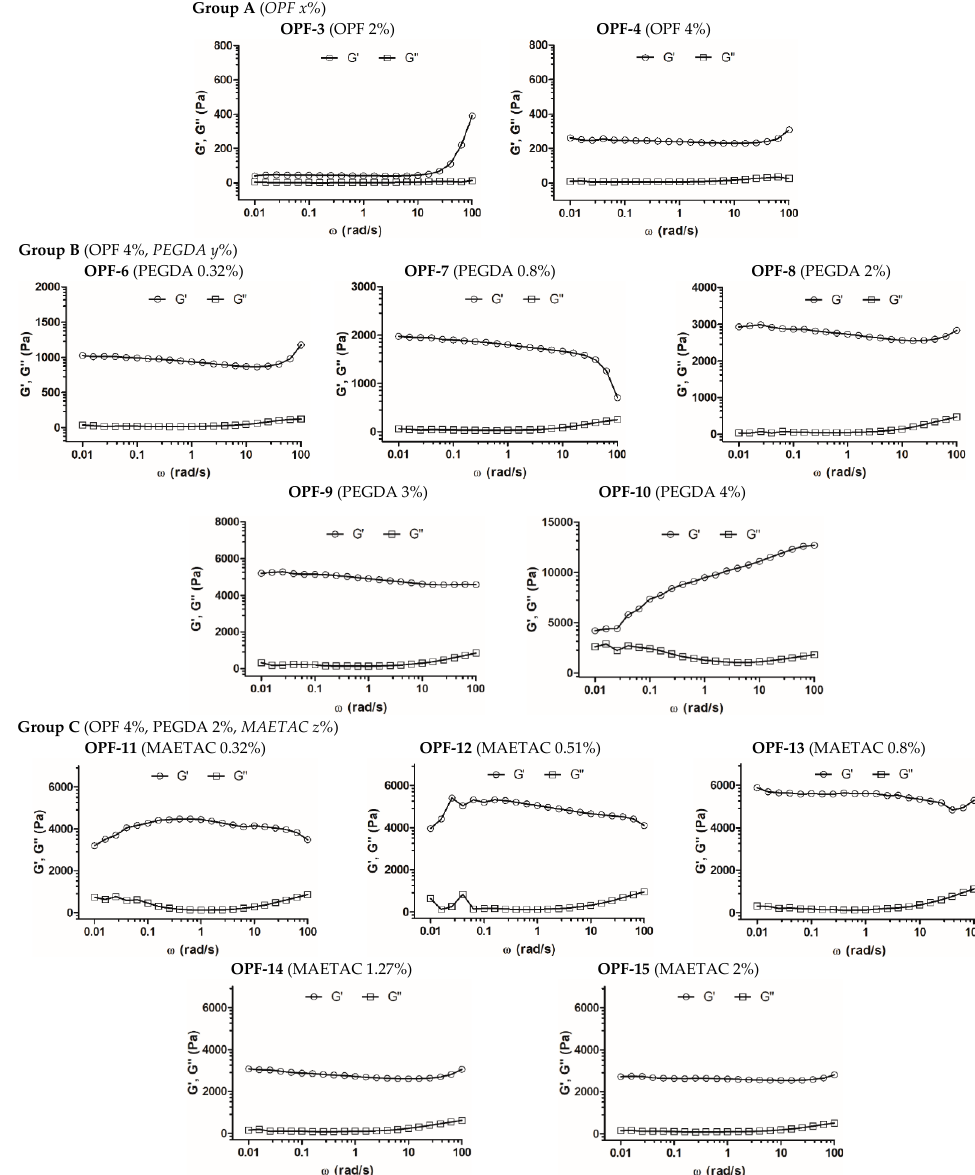
Figure 2. Frequency sweep analysis of OPF-based cryogels. The measurement of frequency depend- ence of storage (G ′ ) and loss (G ″ ) modulus was performed within LVR at δ = 0.5% strain defor- mation. Cryogel compositions (wt. %) are shown in parentheses.